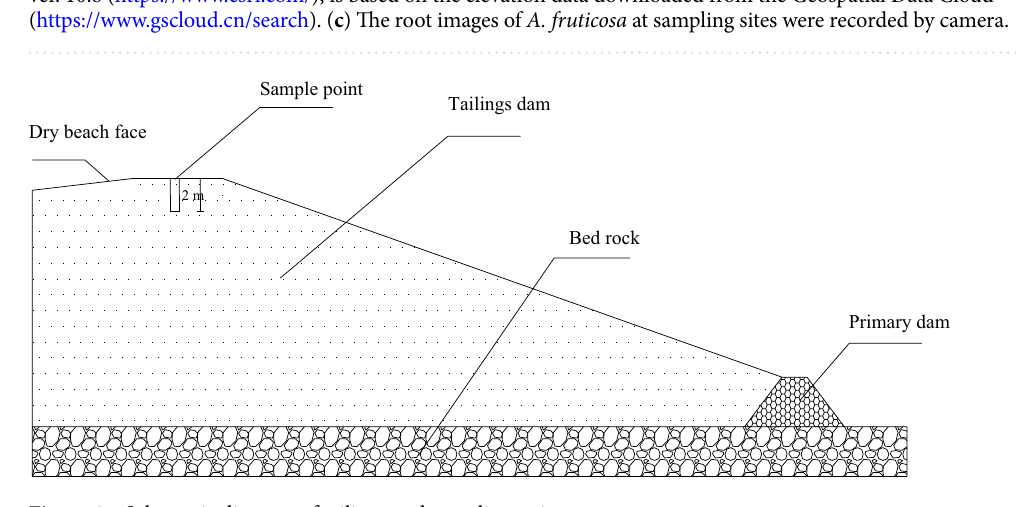
Figure 2. Schematic diagram of tailing sand sampling point.